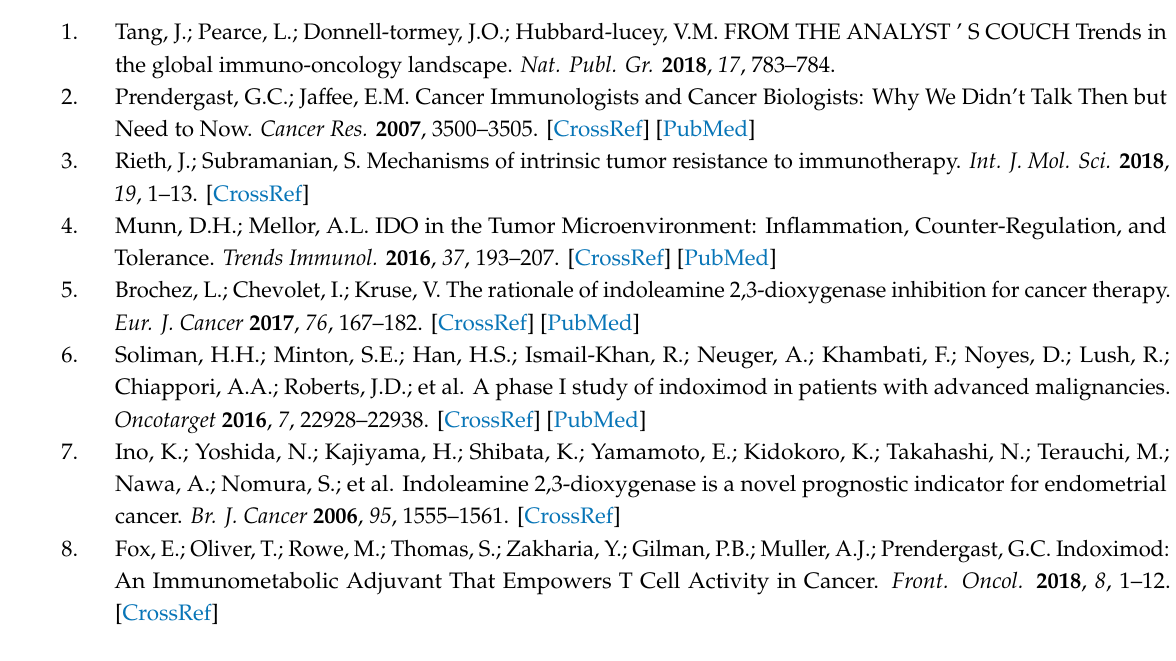
Figure S1: Chromatograms of homopolymer synthesized by condensation